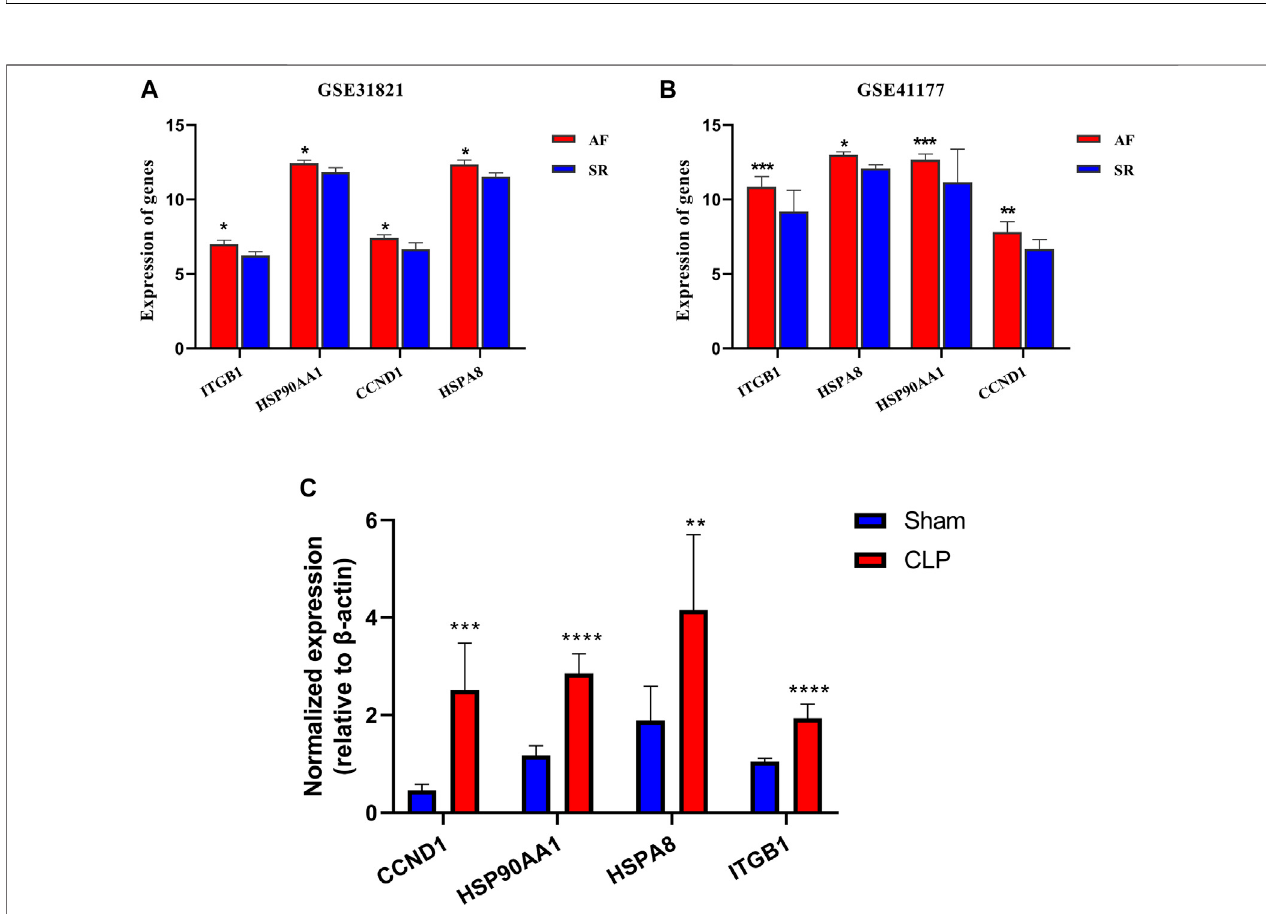
FIGURE 7 | Veri fi cation of key genes in GSE31821 and GSE 41177 and CLP. (A,B) Validation of expression of genes and key genes in patients with AF and SR groupsinGSE31821andGSE41177. (C) Theexpressionsoffourkeygenesinaheartsufferingfromin fl ammatoryrats* p < 0.05,** p < 0.01,*** p < 0.001,**** p < 0.0001.